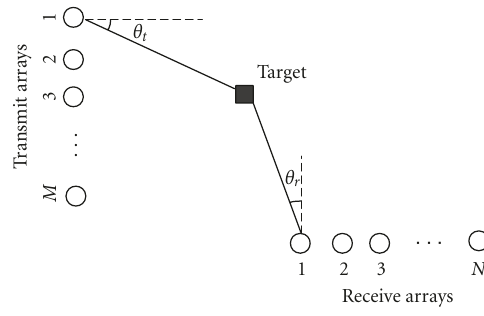
Figure 1: Bistatic MIMO radar